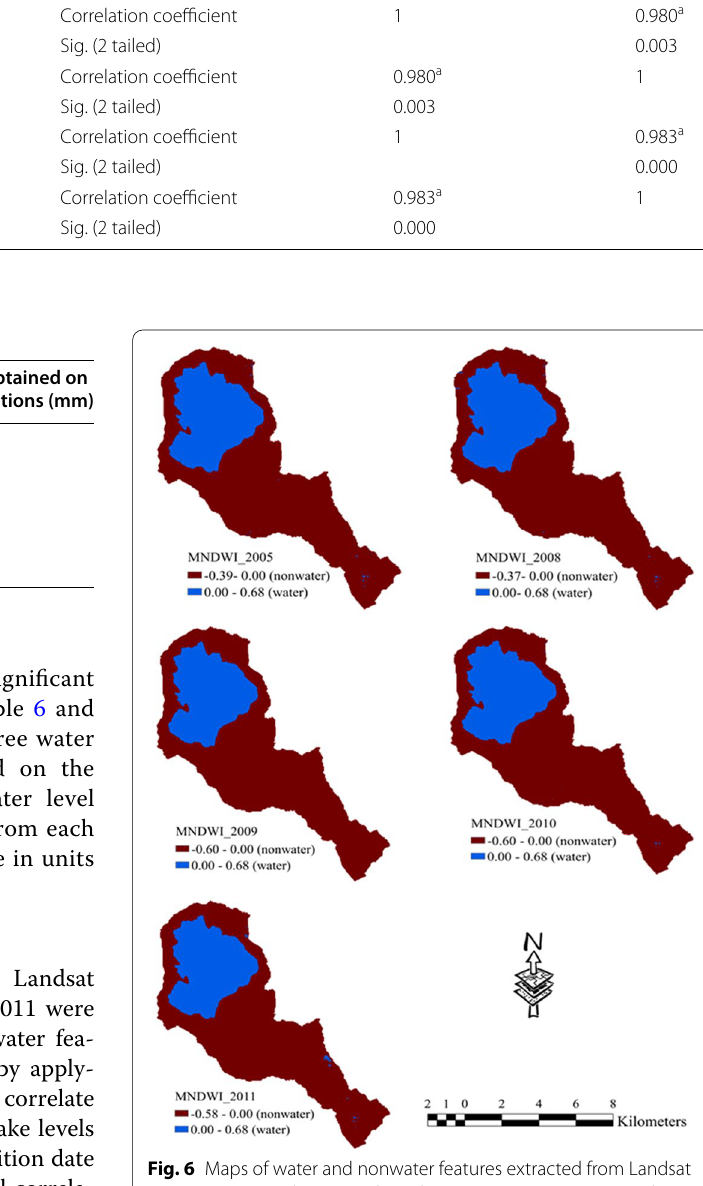
Pearson correlation (Parametric)